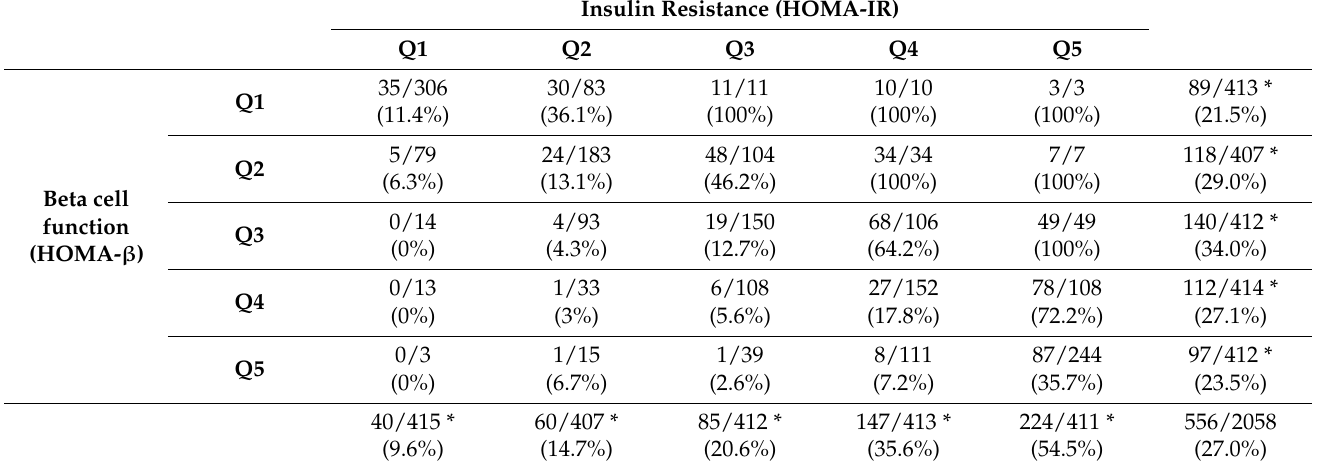
Table 3. Percentage of women with an abnormal second trimester oral glucose tolerance test as a function of insulin resistance and concomitant beta cell